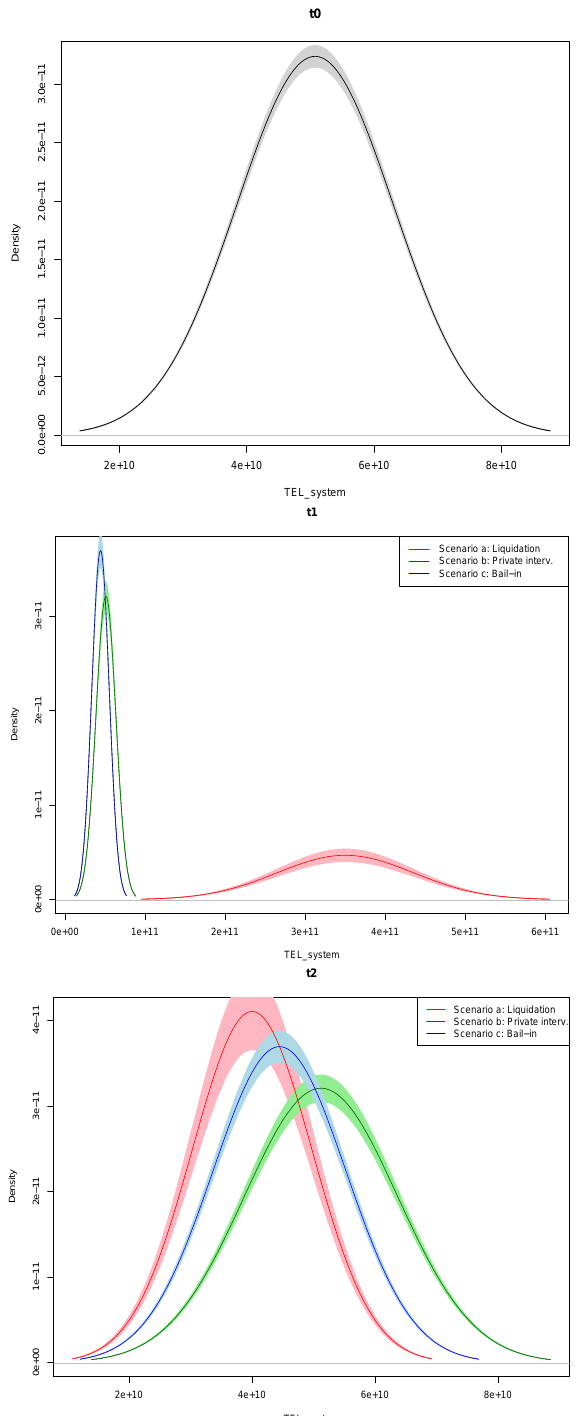
Figure 6. Total expected losses of the system when MPS is in trouble. Notes: Monte Carlo simulated distributions of the expected losses of the entire banking system in case Monte dei Paschi di Siena is close to its default point, calculated at time t 0 ( top ), t 1 ( middle ), and t 2 ( bottom ). Red lines represent the liquidation scenario; blue lines represent the private intervention action; while green lines stand for the bail-in scenario. Expected losses are much lower for Scenarios (b) and (c) at time t 1 , since the shock produced by the liquidation of a big bank strongly increases contagion effects. On the contrary, at time t 2 , the liquidation option reduces financial instability, since the persistence of the troubled bank in the network in case of bail-in or private intervention increases the expected losses of the